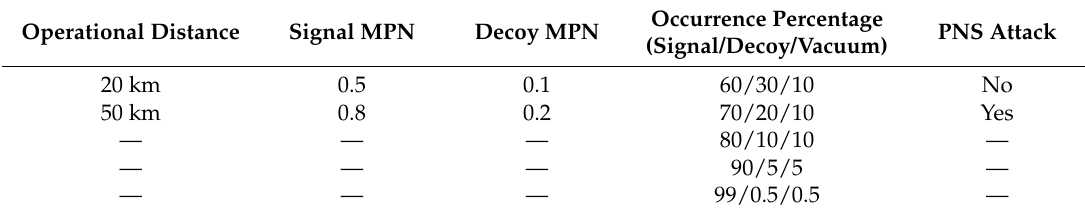
Table 5. Experimental